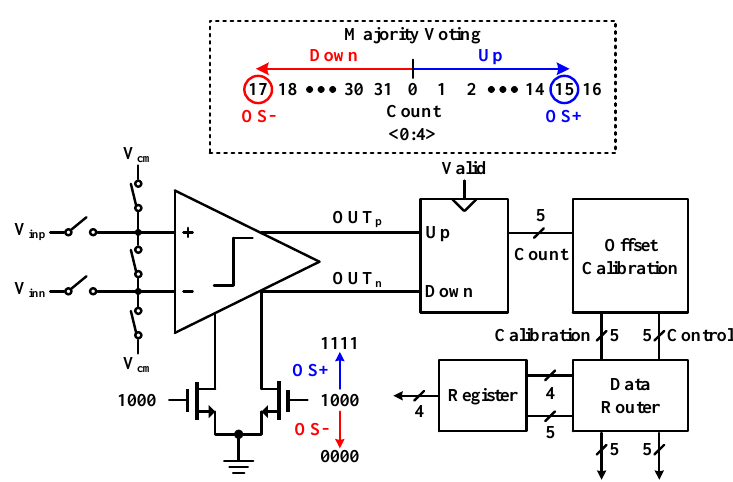
Figure 9. Block diagram of the offset calibration logic with the majority voting scheme.